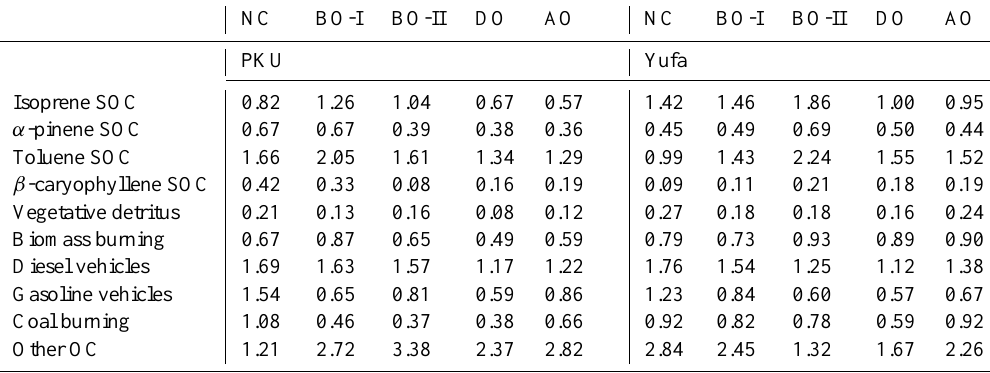
Table 4. Organic carbon contributions from major primary and secondary sources during different periods (µgm − 3 ). NC BO-I BO-II